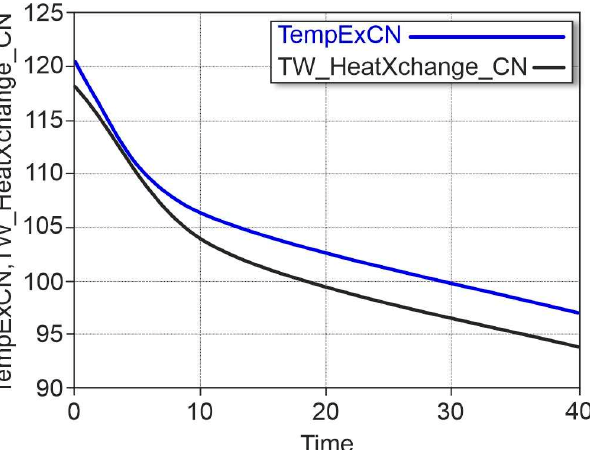
Figure 7. The heat flux in the heat exchanger and the feedback line when warming blood: TW_HeatXchange_CN—change in heat flow in the system circuit; TempExCN—change in heat flow in the feedback line.